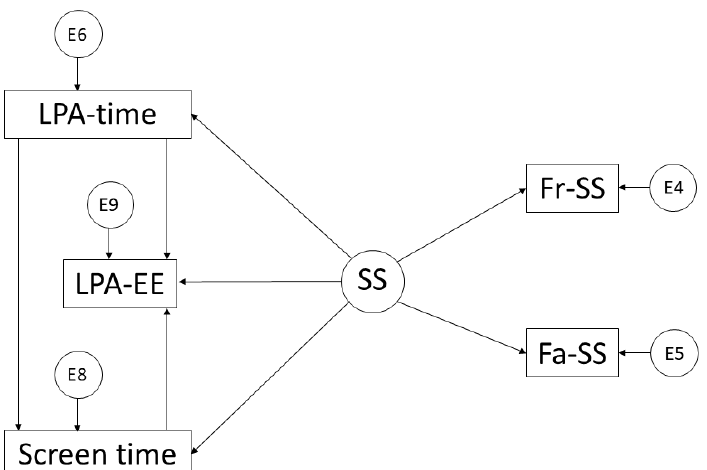
Figure 1. Theoretical model proposed in relation to light physical activity. Light Physical Activity Time (LPA-time); Light Physical Activity Energy Expenditure (LPA-EE); Screen Time (ST); Social Support (SS); Support from Friends (Fr-SS); and Support from Family (Fa-SS).